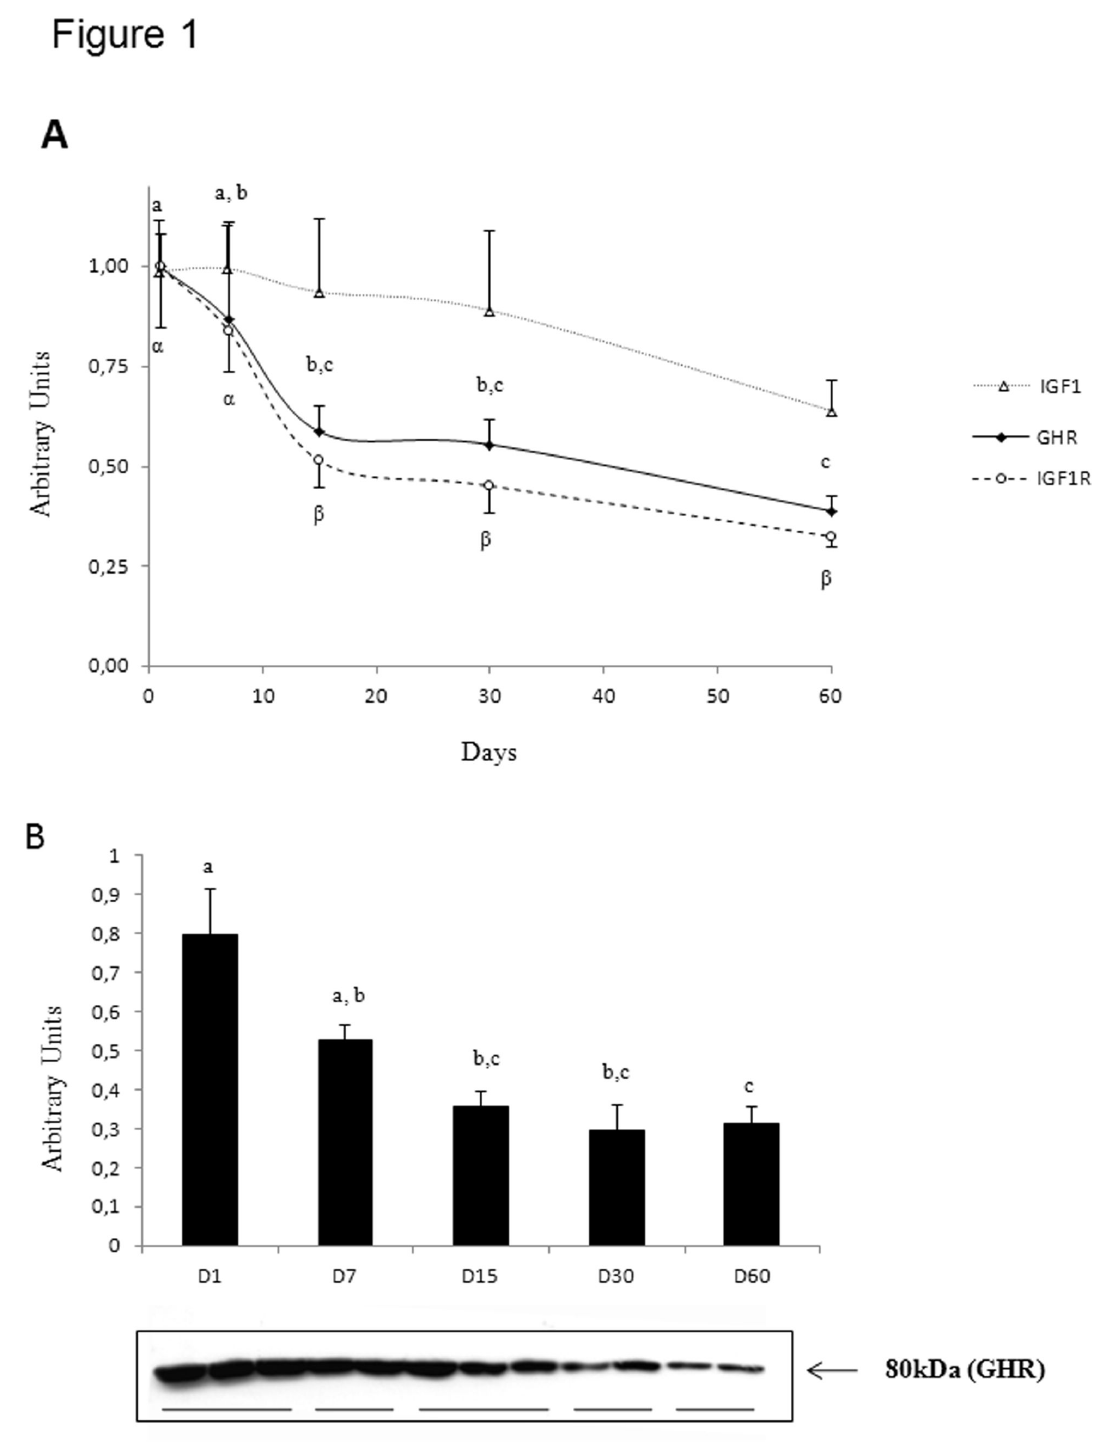
Figure 1. qPCR analysis of the expression of genes involved in growth. Panel A – qRT-PCR analysis of key genes involved in the control of growth, [Insulin-like Growth Factor (IGF-1), its receptor (IGF-1R) and growth hormone receptor (GHR)] in pectoralis muscle from 1, 7, 15, 30 and 60 –day- old Adélie chicks. The relative expression of each gene was expressed as a ratio to the β- actin mRNA level. Panel B - Protein abundance of growth hormone receptor (GHR) from the same chicks. N = 6 per group. Bars correspond to means ± S.E.M. values. Bars with different letters are significantly different at p<0.05. doi: 10.1371/journal.pone.0074154.g001 PLOS ONE |